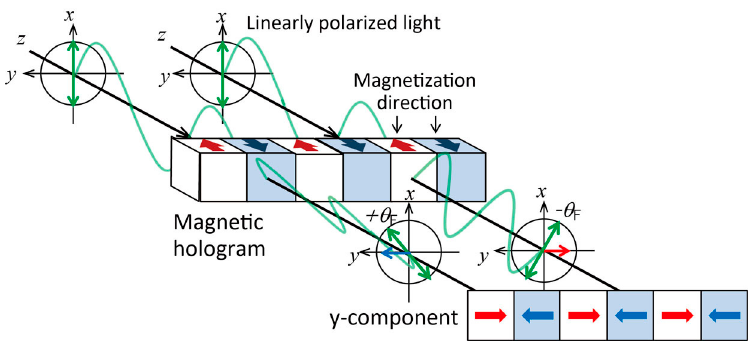
Figure 3. Principle of the reconstruction of magnetic hologram.